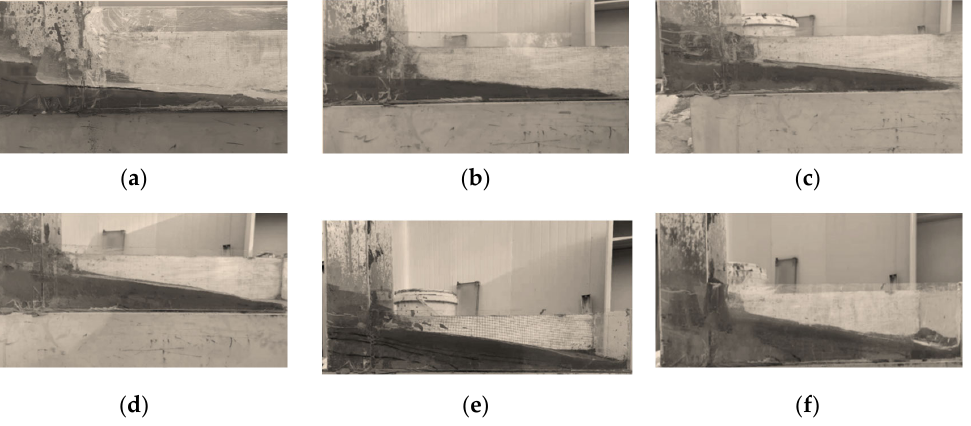
Figure 10. Flow accumulation profile of multilayer backfill body: ( a ) One layer; ( b ) Two layers; ( c ) Three layers; ( d ) Four layers; ( e ) Five layers; ( f ) Six layers. After the filling slurry enters the groove, the shear stress caused by gravity overcomes the yield stress of the slurry itself, resulting in the viscous flow of the slurry [17,18]. Due to the friction resistance between slurry and boundary and the cohesion of slurry, the energy loss causes the slurry to stop flowing and then the slurry enters the initial solidification stage. At the same time, when the shear stress caused by the material’s own gravity balances with the yield stress of the slurry itself, the slurry will be deposited, resulting in the deformation and remodeling of the surface profile of the slurry [19]. With the passage of time, the slurry water loss, slurry from liquid to solid, under the action of its own